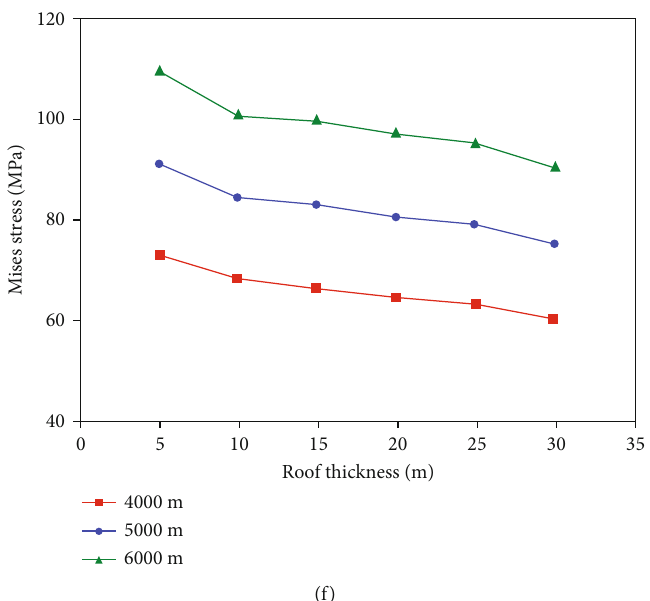
Figure 6: Relation curves of Mises stress to cave span and roof thickness at di ff erent depths: (a, b) cubic cave; (c, d) spherical cave; (e, f) cylindrical